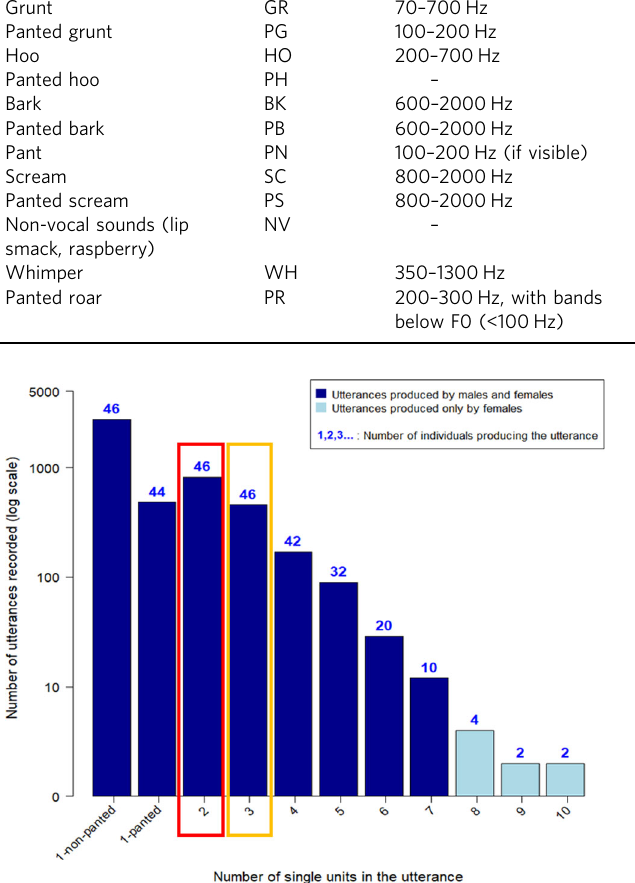
Fig. 1 Frequency distribution of vocal sequences length. The length refers to the number of different single units. The number of single units in the utterance is indicated on the x axis. The y axis depicts the number of recordings (log-transformed for ease of visualization). All utterances with one to seven single units (in dark blue) are produced by both sexes while utterances with eight or more single units (in light blue) are only produced by females. The number on top of each bar in blue indicates the number of individuals producing utterances of this particular length. The red box indicates the data used in the bigram analysis (Figs. 2 and 3) and the orange box indicates the data used in the trigram analysis (Fig.